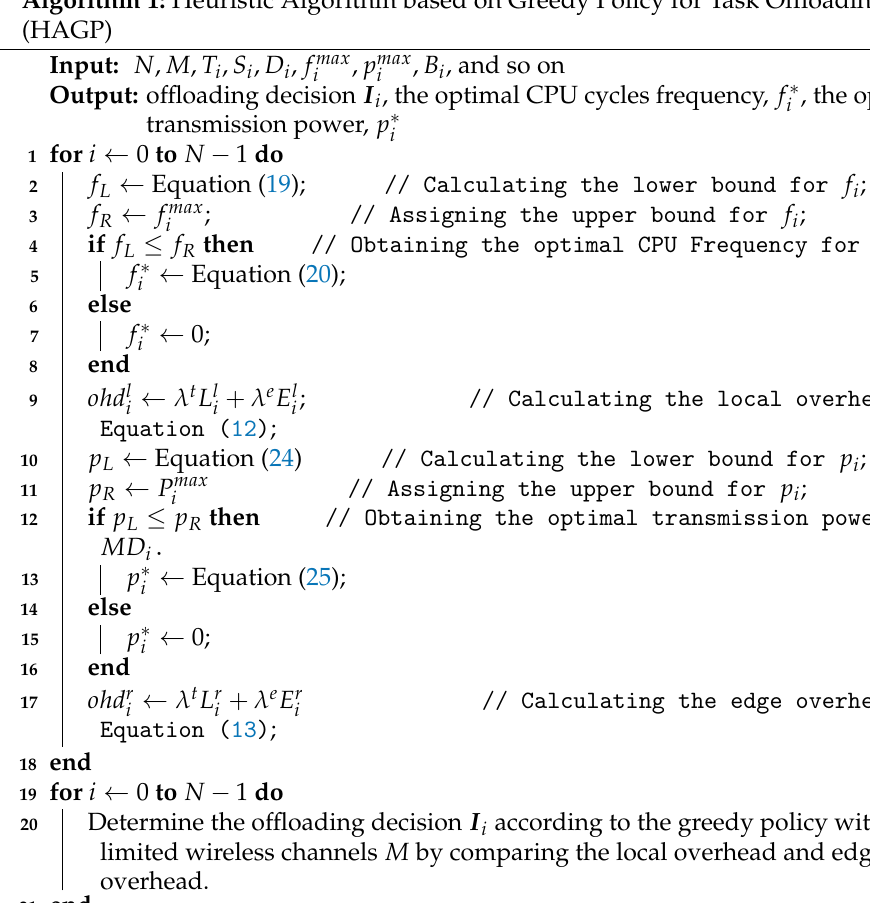
Algorithm 1: Heuristic Algorithm based on Greedy Policy for Task Offloading